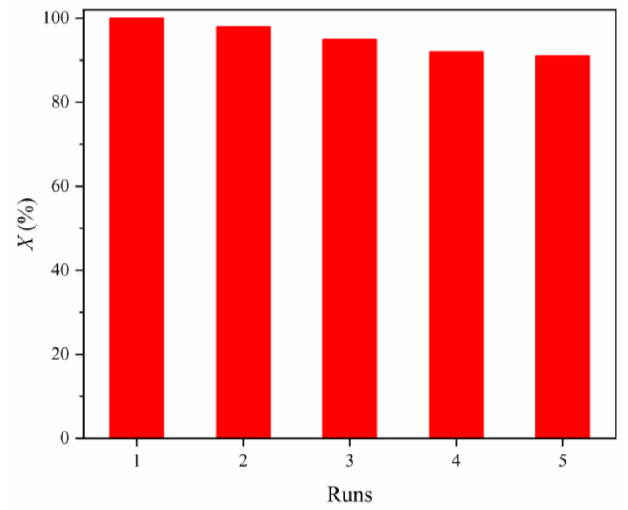
Figure 7. Reusability of Bi 2 W 0.5 Mo 0.5 O 6 photocatalyst. Reaction conditions: 10 mL of model fuel, 200 ppm S, 0.1 g of photocatalyst, H 2 O 2 /DBT molar ratio of 10, 30 W LED lamp as the visible light source, and a distance of 10 cm from the light source to the model fuel .